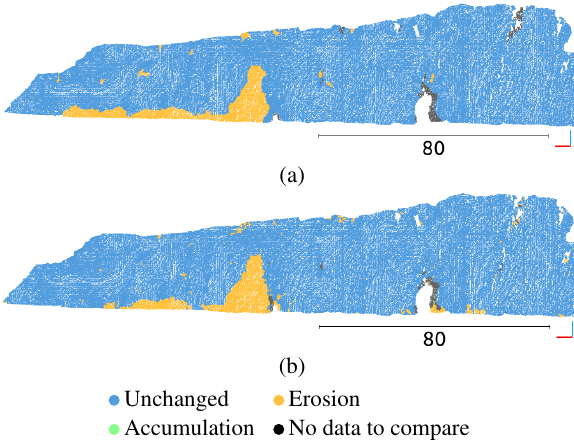
Figure 6. Results on west part of the cliffs between 2018 and 2020 acquisition. Points of the ground truth (a) and in Siamese KPConv results (b) are colorized according to the